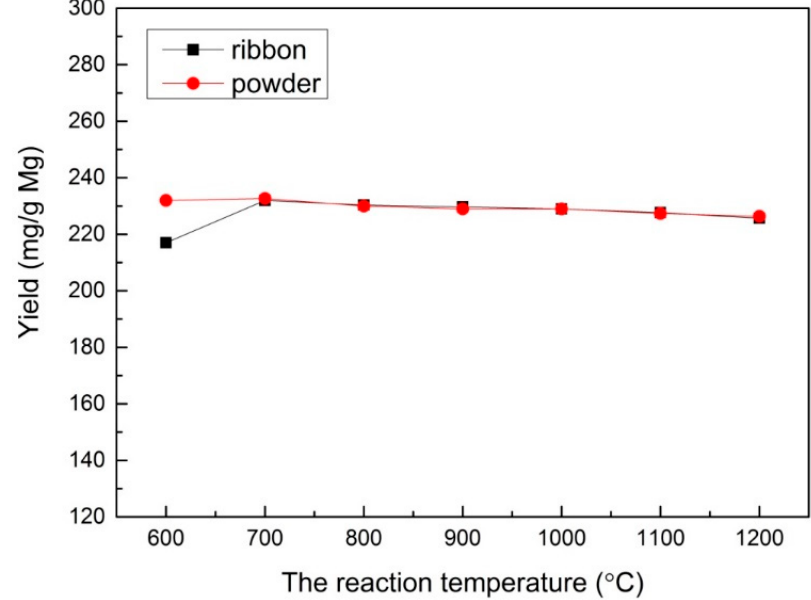
Figure 3. The yield under different reaction temperatures prepared with an Mg ribbon and Mg powder.